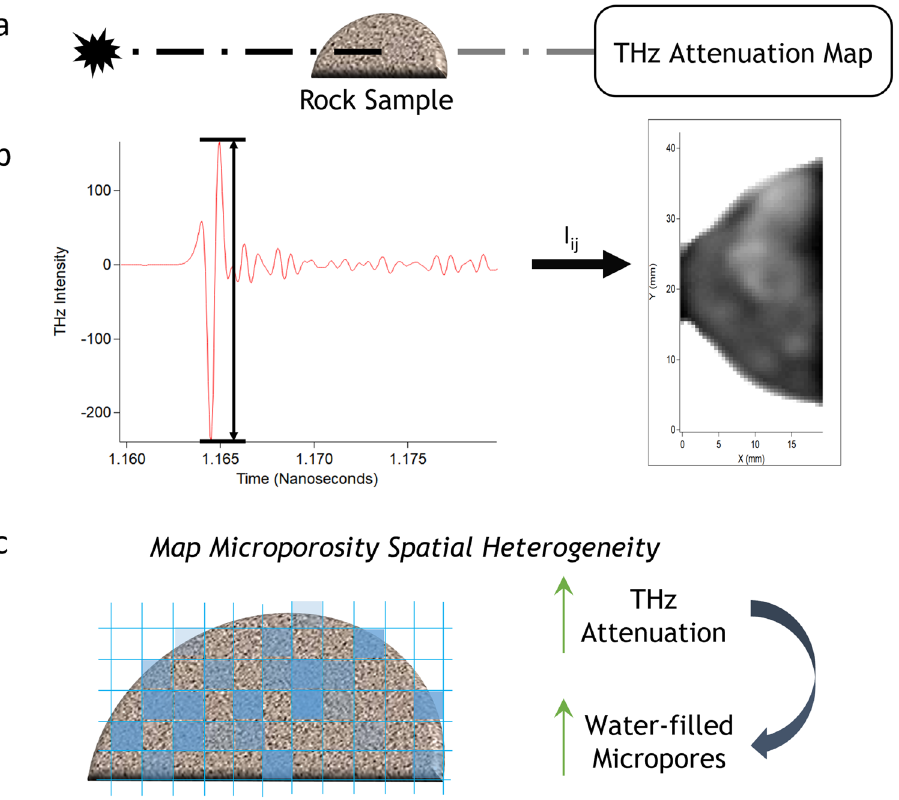
Figure 1. Schematic of the measurement scheme and conceptualized results. ( a ) The Terahertz (THz) beam of I 0 passing through the rock sample and the reduced intensity, I ij , due to attenuation that produced the attenuation map. ( b ) The THz-TDS pulse (red) and the marked peak-to-peak amplitude (black) used to generate the attenuation map where the darkest pixels are the most attenuating and the brightest the least. ( c ) Conceptualized results showing that with increasing water-filled pores the THz attenuation